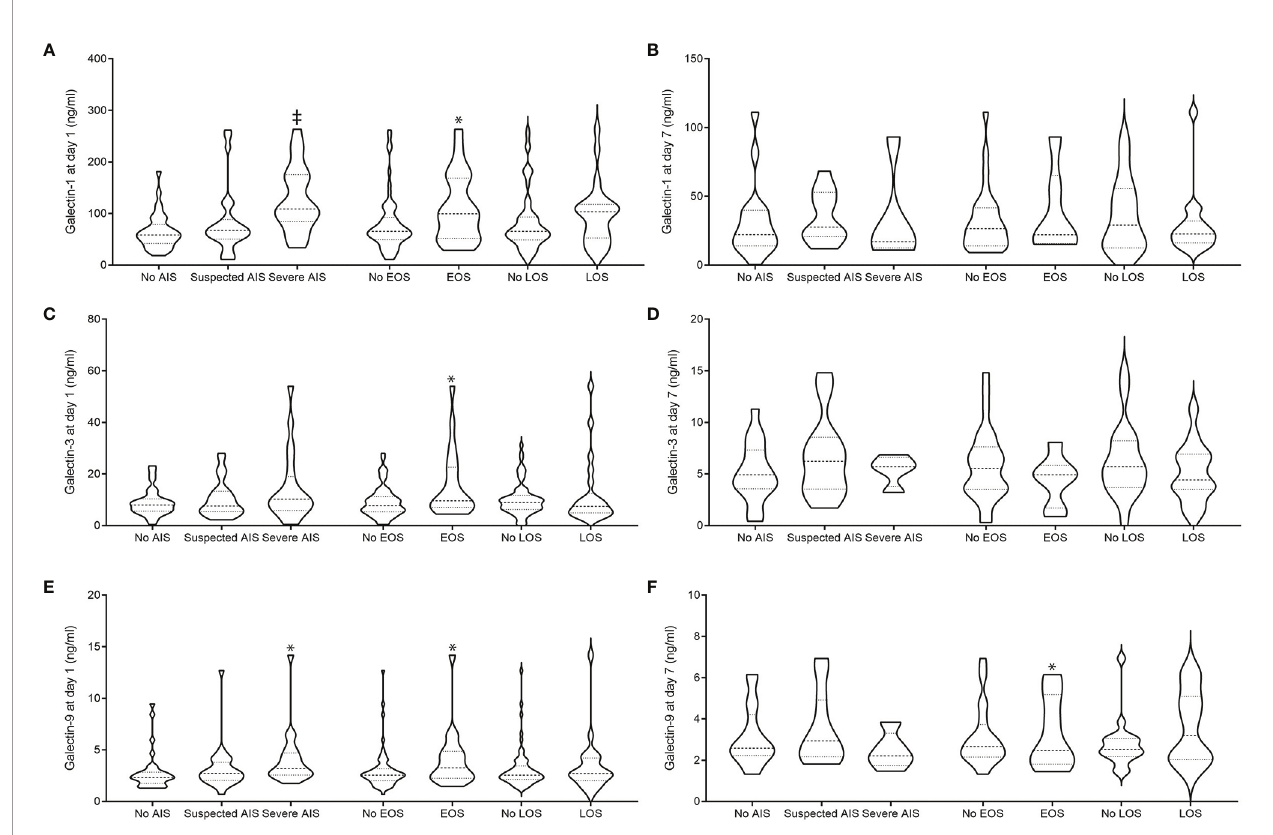
FIGURE 2 | Peripheral blood gal-1 (A, B) , gal-3 (C, D) , and gal-9 (E, F) levels in relation to AIS and EOS at day 1 (A, C, E) and 7 (B, D, F) of life AIS was diagnosed clinically: de fi nite signs were noted: maternal fever or fetal tachycardia, maternal increase in white blood cell count >10/ml or c-reactive protein levels (> 20 mg/L) without other focus of infection, painful uterus, foul-smelling amniotic fl uid, and either preterm labor or preterm rupture of membrane. Suspicion of AIS was diagnosed with one clinical sign. EOS was diagnosed along the NEO-KISS criteria (clinical sepsis or blood-culture proven sepsis). *P < 0.05 and ‡ P < 0.025 as analyzed by Mann-Whitney U-test (EOS) and Kruskal-Wallis